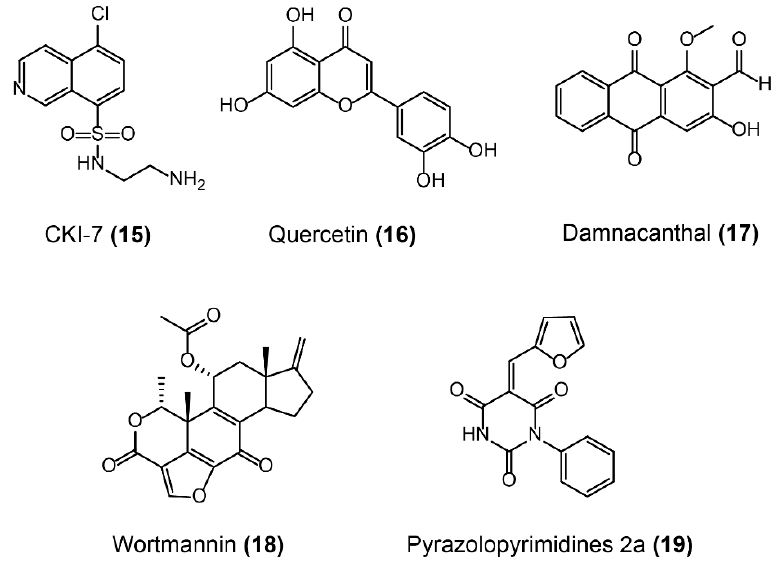
Figure 12. Inhibitors of APHs.